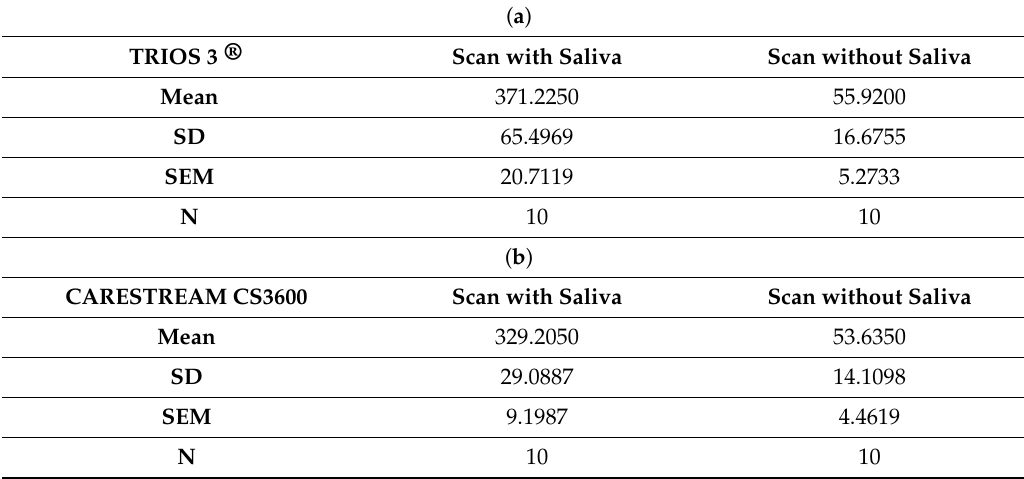
Table 13. t -test sample